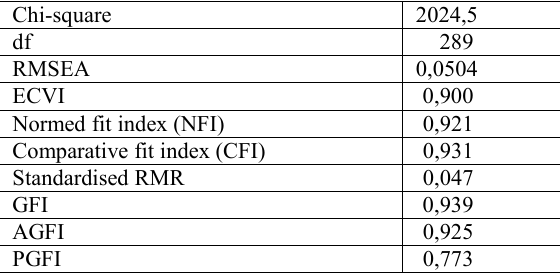
Table 4: Model fit